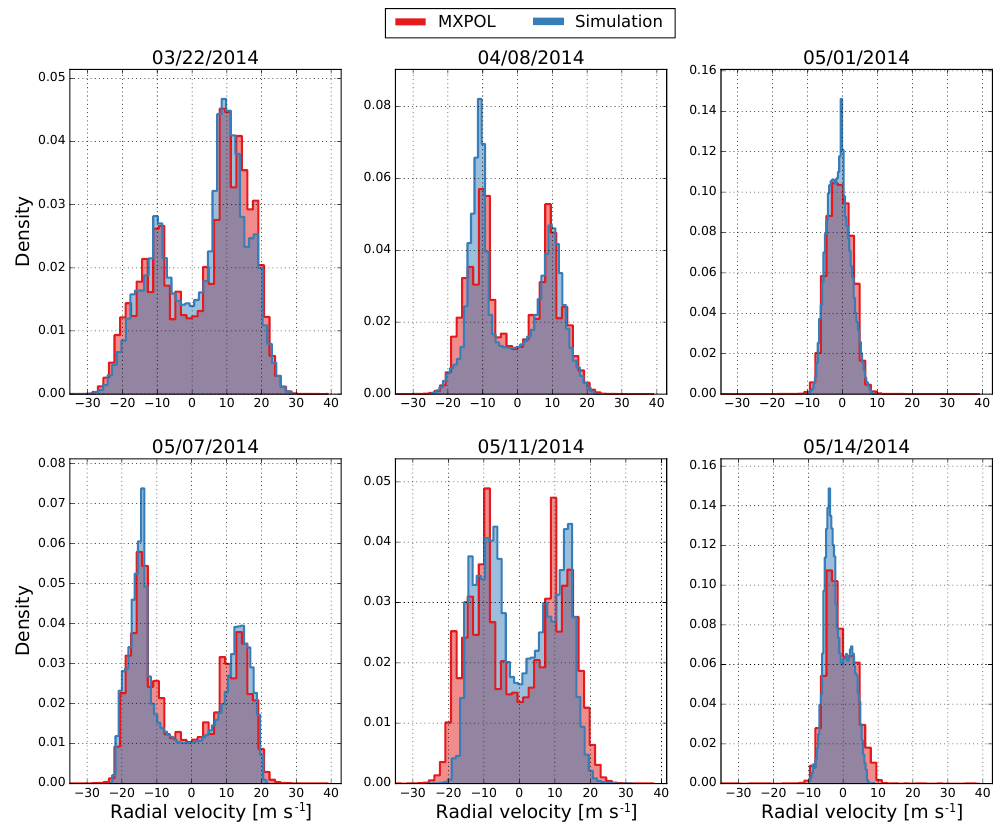
Figure 14. Distributions of simulated (blue) and observed (red) radial velocities at X-band during six days of precipitation in Western Switzerland.